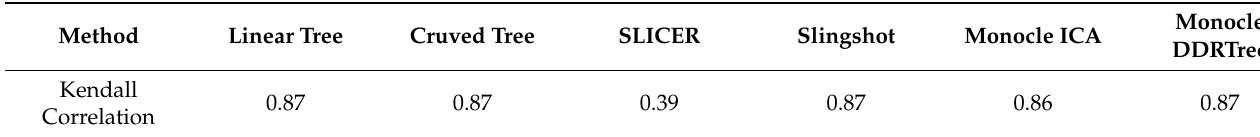
Table 3. Kendall correlation for all methods on the mouse ES cell dataset.